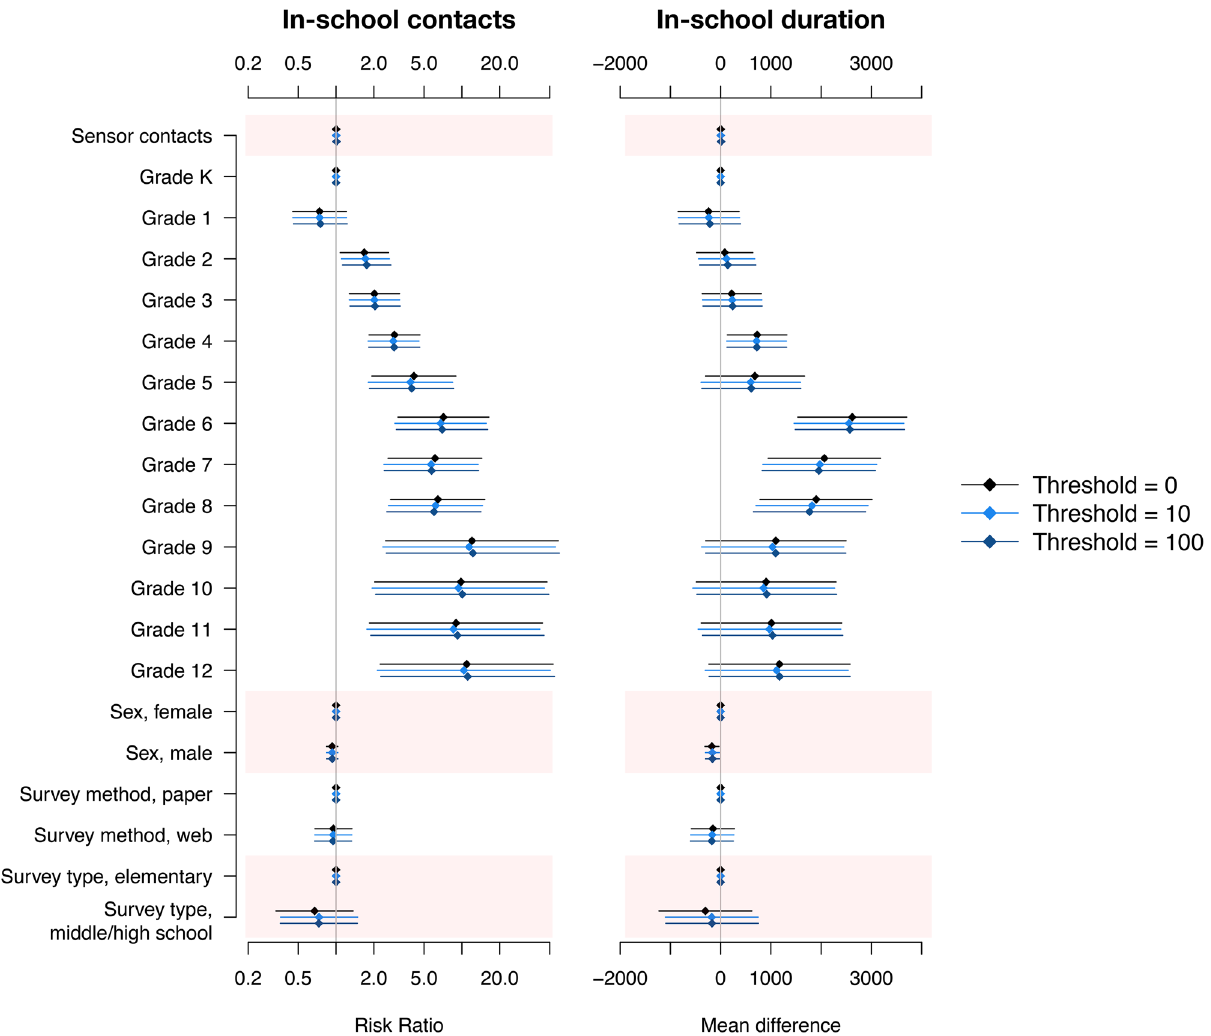
Figure 2. Factors associated with the number and duration of survey-reported in-school contacts in a US school setting. All models include a random intercept for day of survey